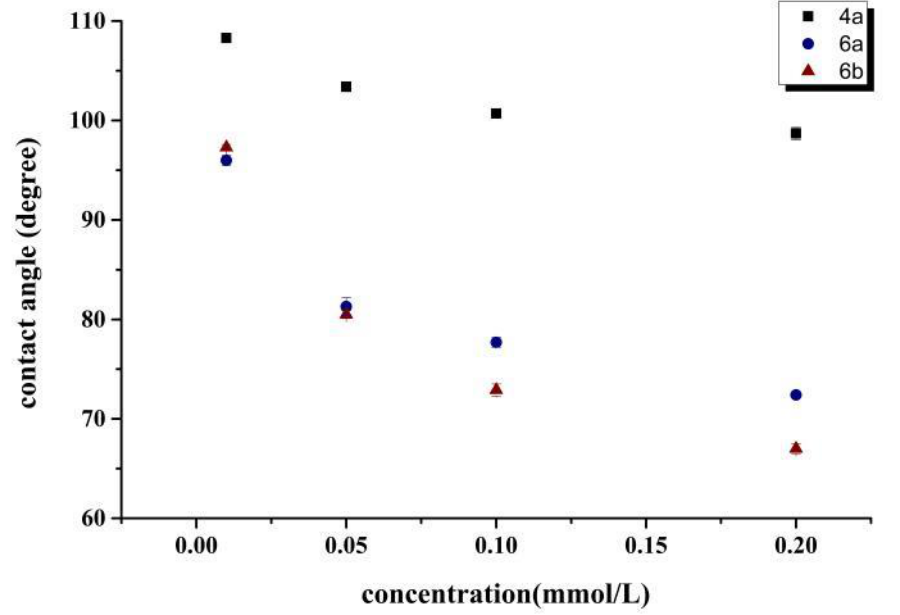
Figure 9. Contact angles of 4a , 6a , and 6b at various concentrations.